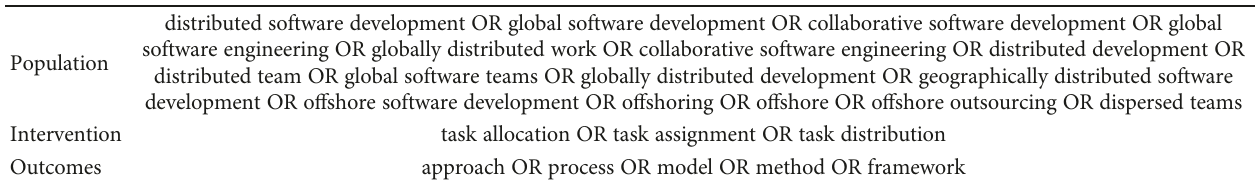
Table 3: Parameters of search